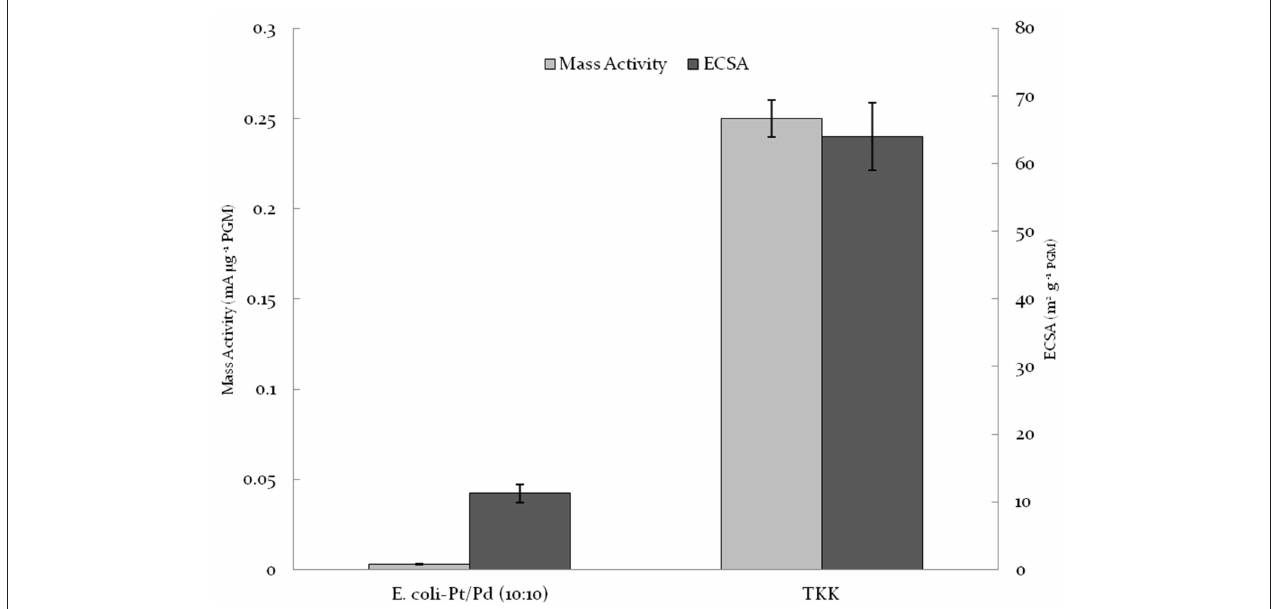
FIGURE 9 | Comparison of E.coli -Pt/Pd (10%/10%) mass activities and ECSA against TKK. Note that the loading of Pt on TKK is nearly 50% whereas that on biomass is 20 wt% in total. The specific activity (mA/g metal) is shown but the conductivity between metallic NPs separated by carbon or biomass is not